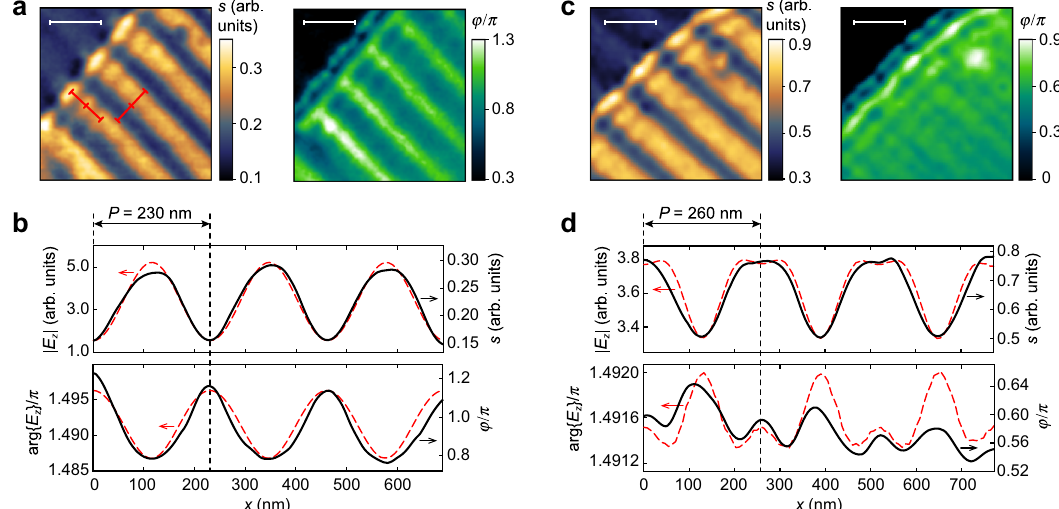
Fig. 5 Near- fi eld pro fi le of AGP across the gold nanoribbons. a Near- fi eld signal amplitude s ( x , y ) and phase φ ( x , y ) at the sample with P = 230 nm ( t = 18 nm, E F = – 0.62 eV, λ AGP ≈ 228 nm) at ω = 1200 cm – 1 when the AGP momentum k AGP is similar to the array momentum 2 π / P (indicated by the identical red scale bars of 230 nm). b Pro fi les of s ( x , y ) (top panel) and φ ( x , y ) (bottom panel) shown in ( a ), measured across the nanoribbons (black solid), and the numerically obtained (red dashed) by the full-wave FEM simulations | E z | (top panel) and arg{ E z } (bottom panel). c Same as in ( a ), measured at the sample with P = 260 nm ( t = 18 nm, E F = – 0.52 eV, λ AGP ≈ 225 nm) at ω = 1150 cm – 1 when k AGP > 2 π / P . d Same as in ( b ), showing the irregular near- fi eld pro fi le attributed to the mixed signal form the several array modes. White scale bars are 300